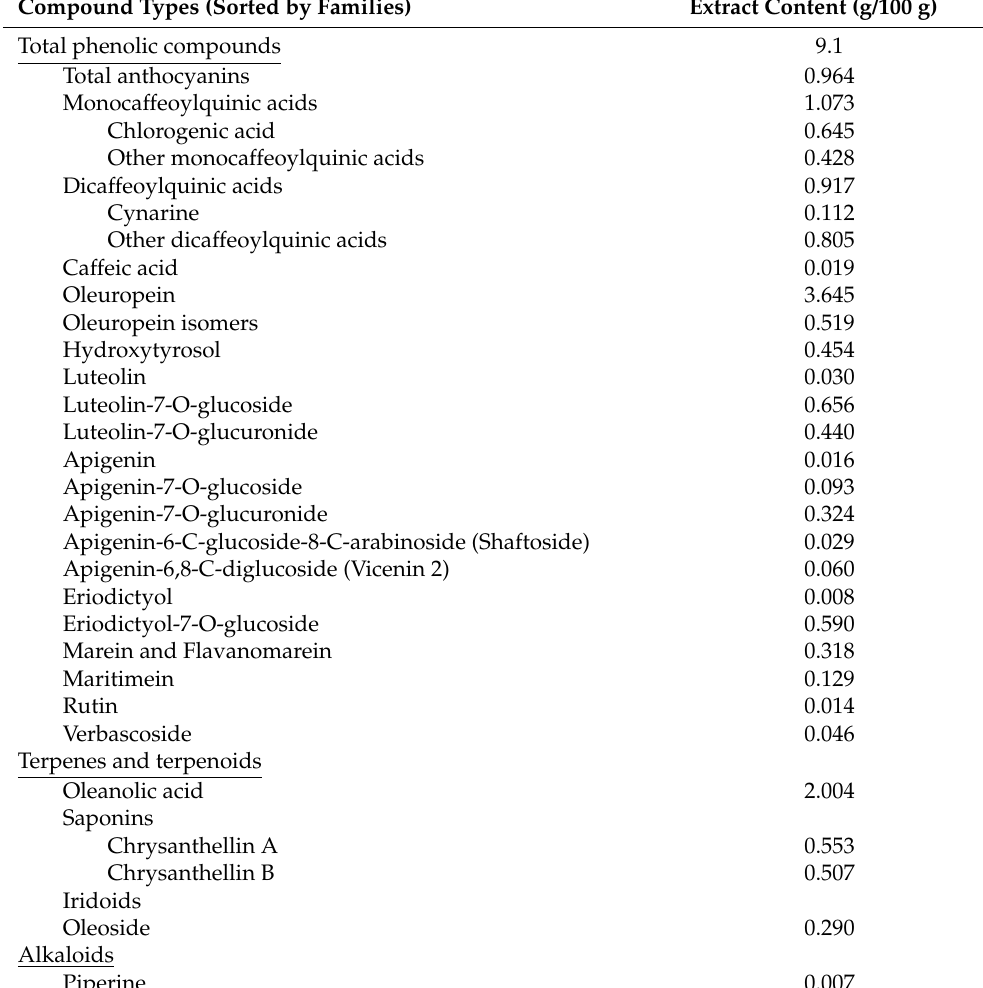
Table 2. Phytochemical characterization of TOTUM-63.